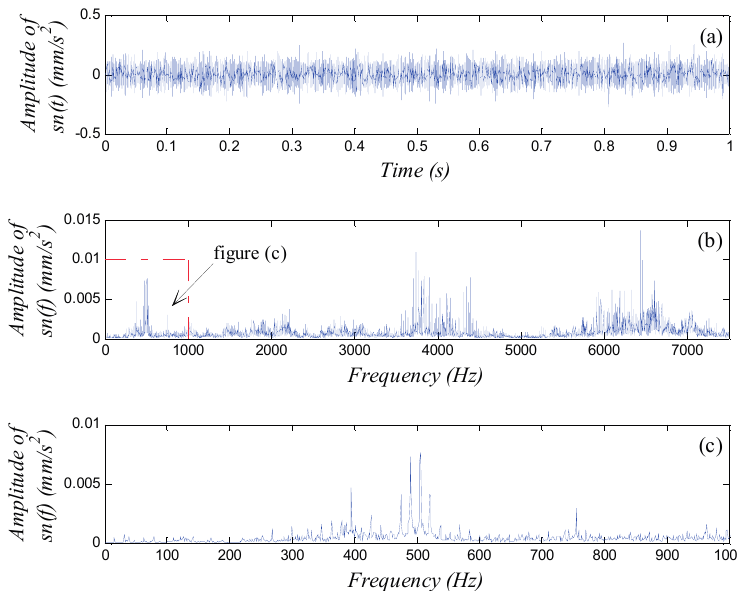
Figure 11. Vibration signal analysis of an outer ring fault in a rolling bearing: ( a ) waveform; ( b ) global spectrum; ( c ) low-frequency